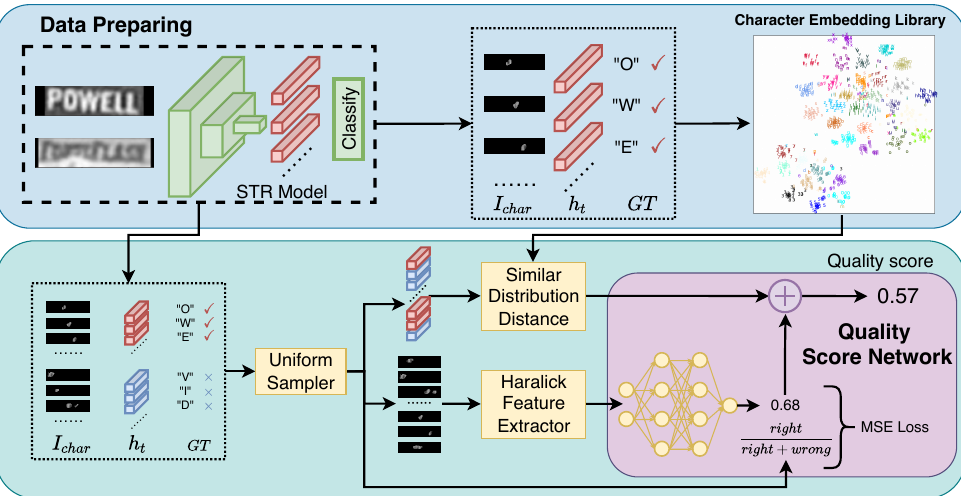
Figure 2. An overview of FSR-TIQA. Step 1: The character embedding and the corresponding character image region are obtained by traversing the real-world text images in the pre-trained STR model. The character embedding library is collected. Step 2: The paired data obtained by the uniform sampler are used to extract the Haralick feature and Wasserstein distance, respectively. Step 3: The score network is trained under the constraints of the whole batch recognition